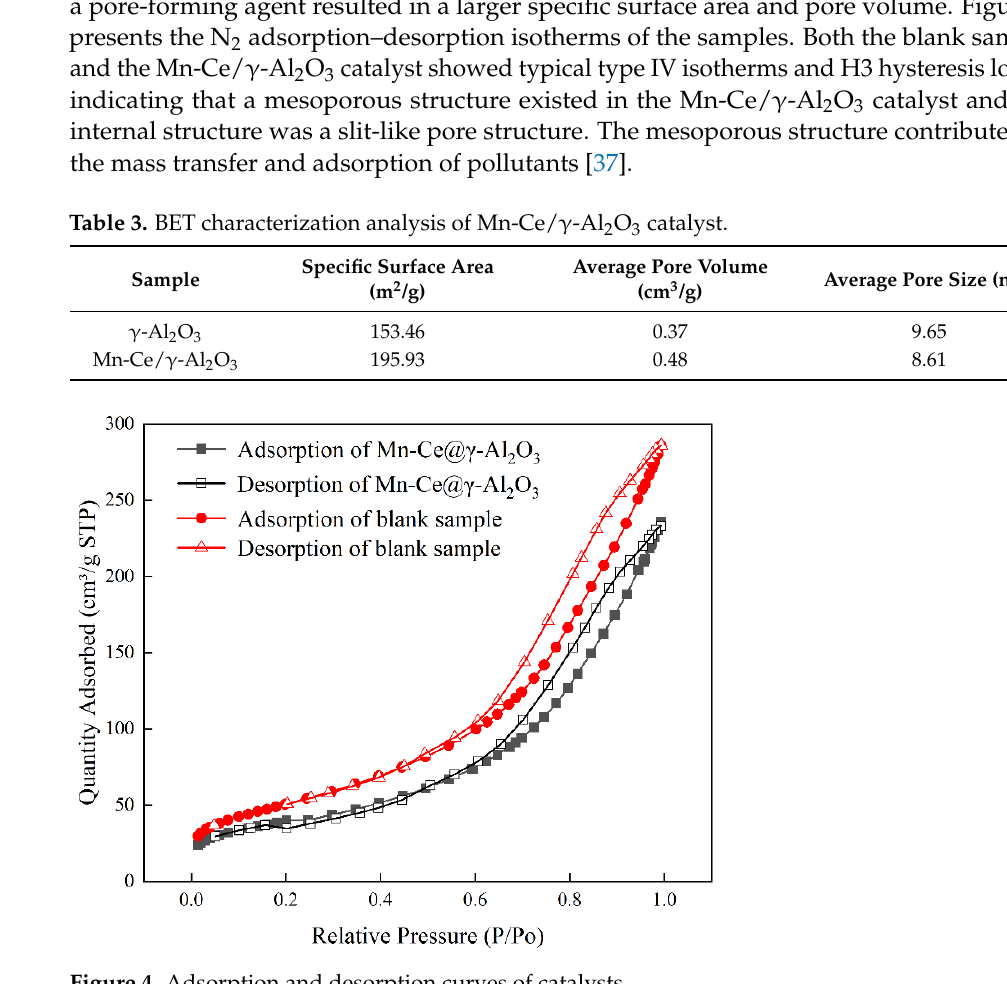
Figure 4. Adsorption and desorption curves of catalysts. Table 3. BET characterization analysis of Mn-Ce/ γ -Al 2 O 3